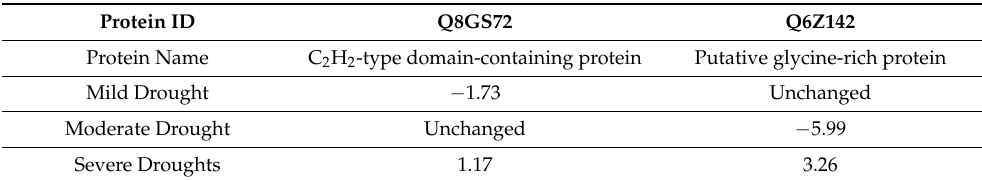
Table 3. Protein abundance (fold-change) under various drought stress conditions for two proteins with unusual patterns of changes in